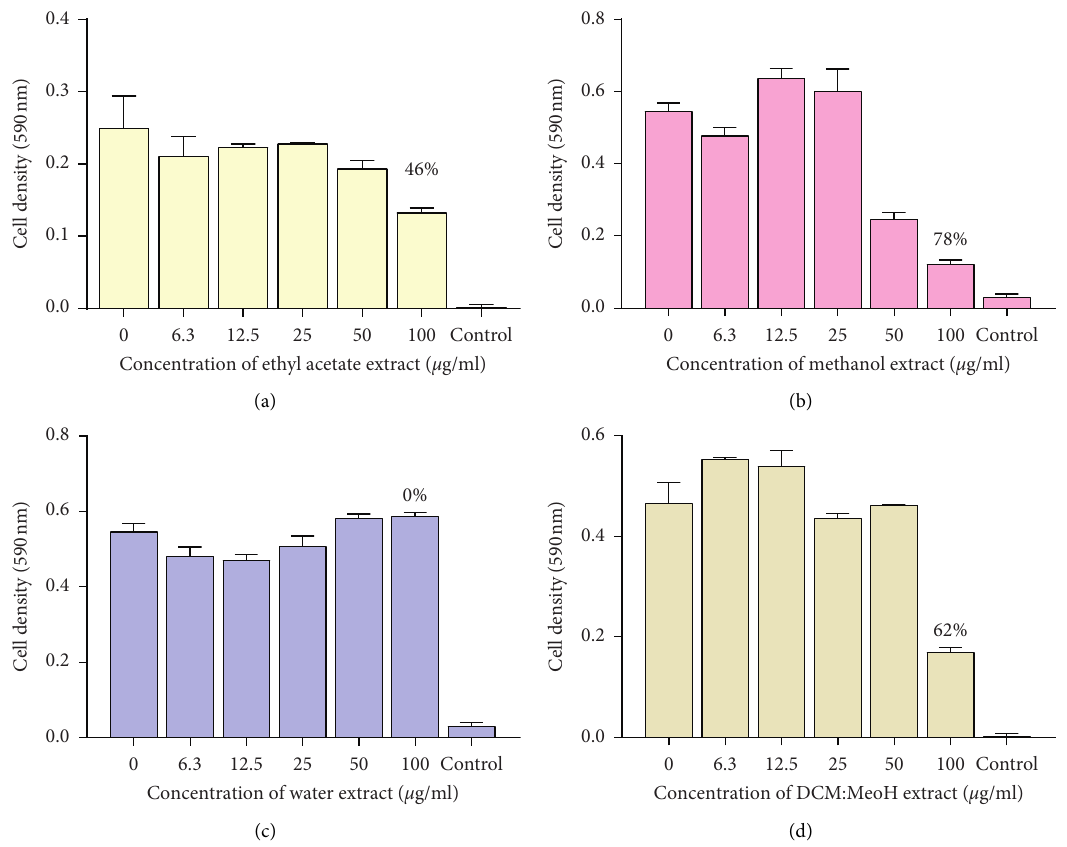
Figure 3: The effects of extracts of pods of P. thonningii against M. smegmatis : (a) effect of ethyl acetate extract, (b) effect of methanol extract, (c) effect of water extract, and (d) effect of DCM: MeOH extract. Concentrations of extract ranged from 6.3 μ g/mL to 100 μ g/mL. Values are in mean cell density at 590nm wavelength ± the standard deviation; N �